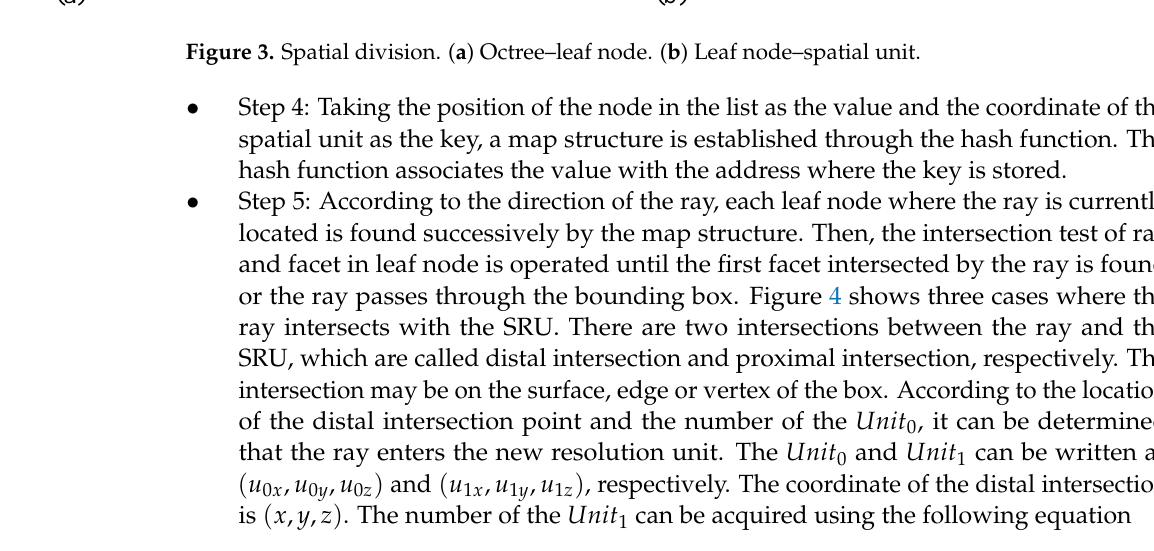
Figure 3. Spatial division. ( a ) Octree–leaf node. ( b ) Leaf node–spatial unit.